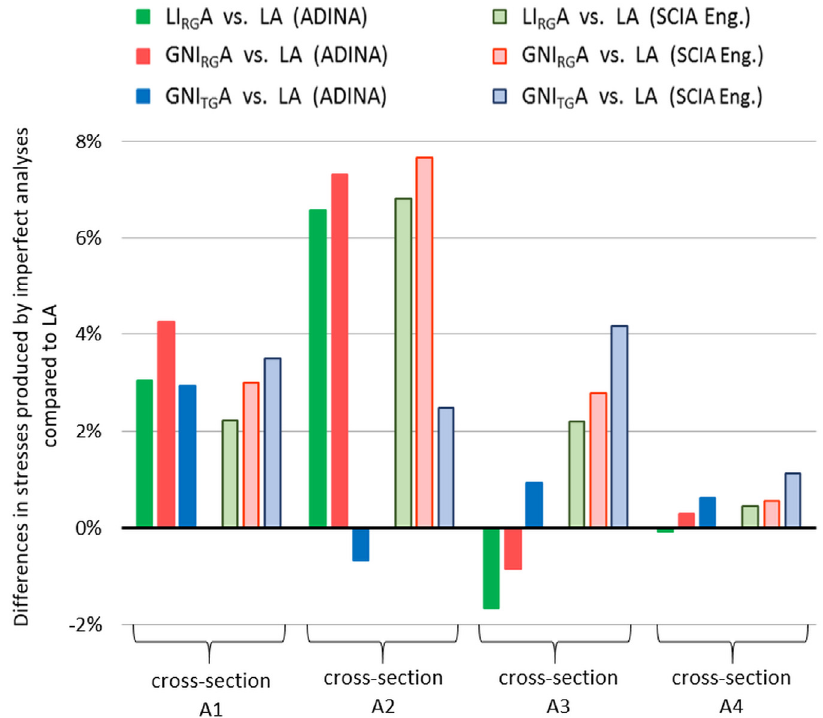
Figure 10. Percentage differences in the stresses produced by the analyses with the imperfections included (LI RG A, GNI RG A and GNI TG A) compared to the simple linear analysis (LA). The absolute values of differences are small, but relative variation between the four chosen arch